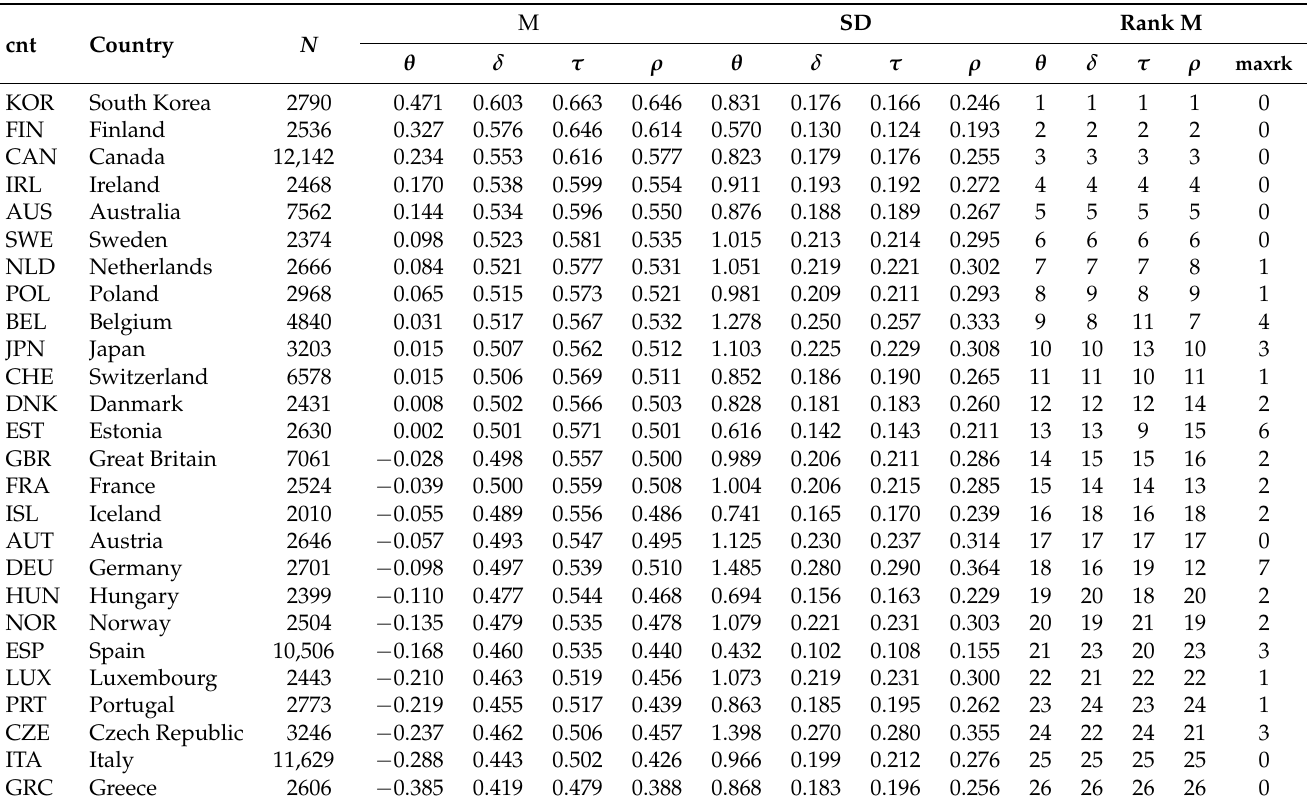
Table 2. Country-level results for PISA 2006 reading for different ability